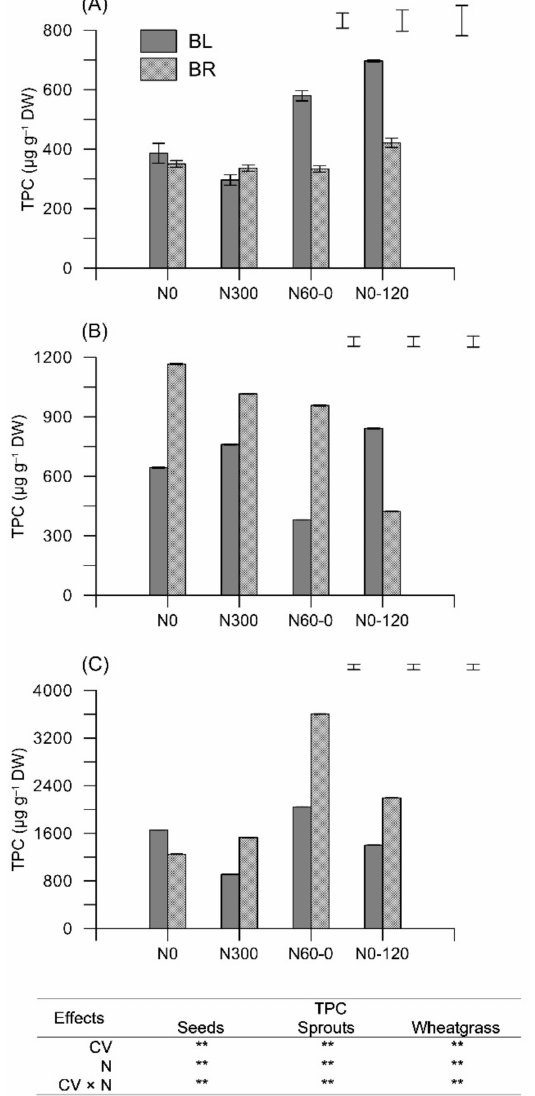
Figure 2. Total phenolic content (TPC) (Folin–Ciocalteu, FC; µ g gallic acid equivalents g − 1 dry weight, DW) as determined in seeds ( A ), sprouts ( B ), and wheatgrass ( C ) obtained from two Triticum aestivum cultivars (Bologna, BL; Bora, BR) subjected to four different N fertilization schedules (N0: unfertilized control; N300: constantly well N fertilized throughout the growth cycle; N60-0: N fertilized only one month after sowing; N0-120: N fertilized only late at initial shoot elongation). In the box, F-test from the analysis of variance (ANOVA): two-factor ANOVA at 5% level of probability; cultivar (CV); N fertilization schedules (N). ** p < 0.01; Bars represent the Least Significant Difference (at p < 0.05) for CV, N, and CV × N (from left to